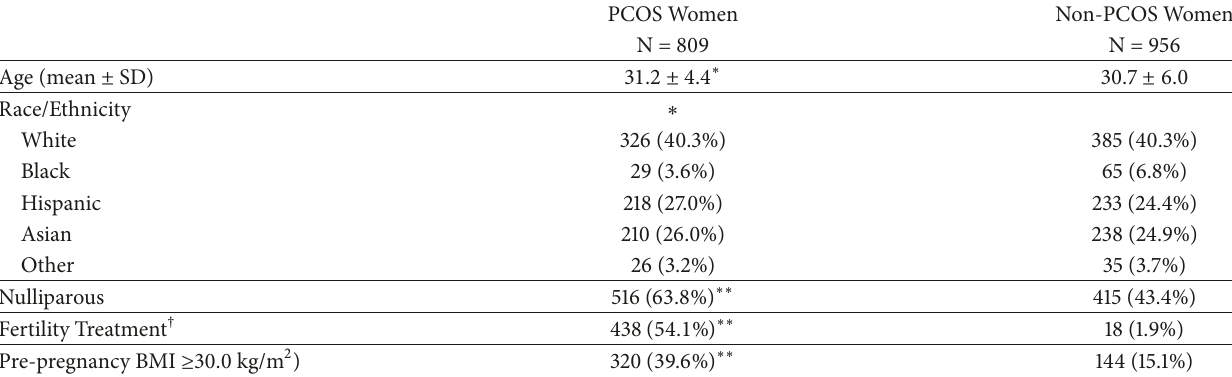
Table 1: Baseline characteristics of women with singleton pregnancy and no preexisting hypertension by polycystic ovary syndrome